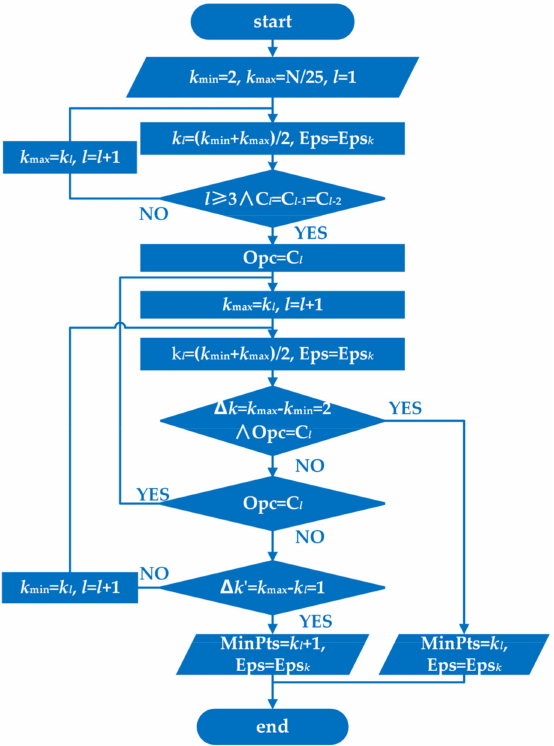
Figure 1. The procedure of parameter seeking based on the dichotomy, where k is rounded to the nearest